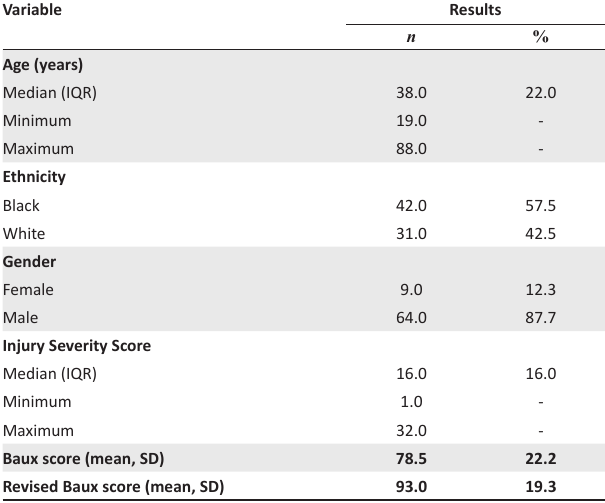
FIGURE 1: Diagram of records screened and included in our review.